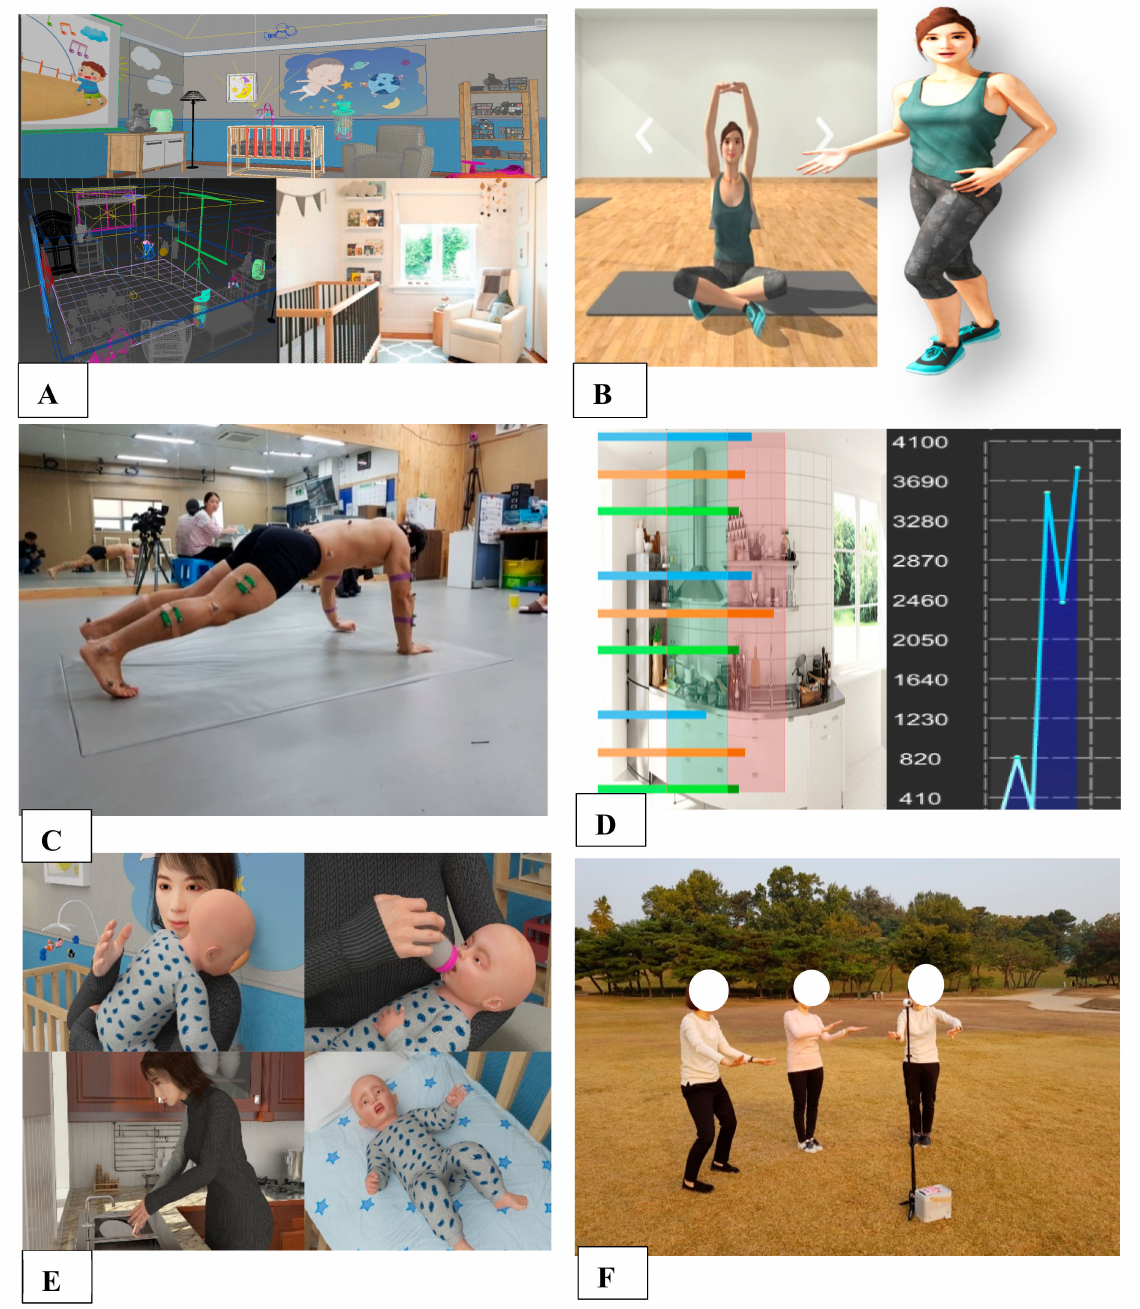
Figure 2. Images of the postpartum self-management VR program. Note: VR = virtual reality; ( A ) = home screen on Android; ( B ) = a type of exercise in the exercise program; ( C ) = capture of the movement/motion of an actual fitness trainer with the recording of the trainer’s voice; ( D ) = evaluation of the participants’ diet based on the body mass index; ( E ) = neonatal first aid program; ( F ) = laughter therapy using 3D or 360 ◦ techniques for stress